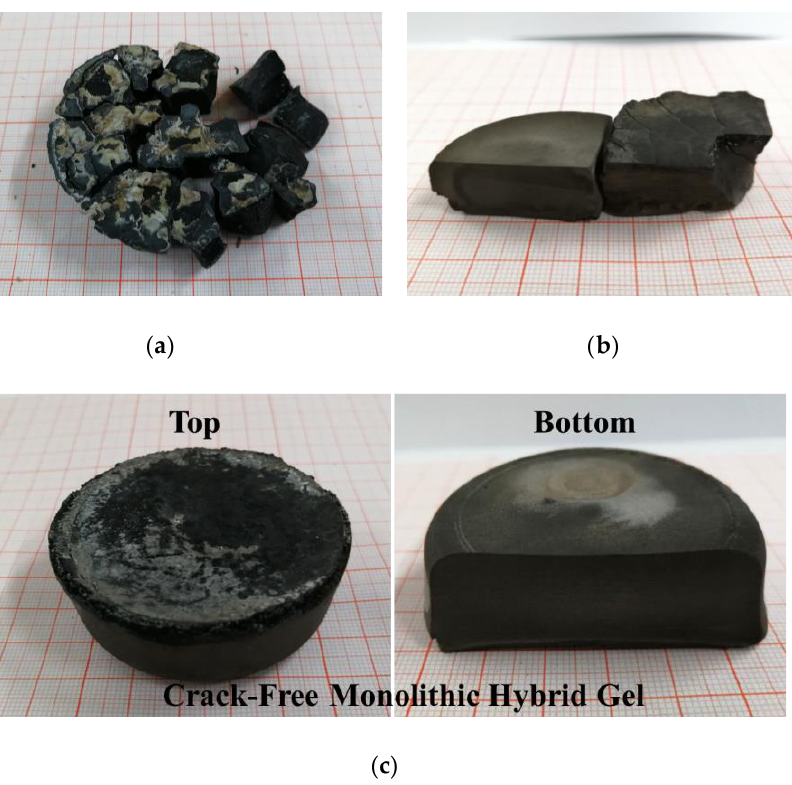
Figure 3. Photographs of the hybrid gels with various SDS concentrations in the starting sols: ( a ) SCB-S0; ( b ) SCB-S0.5; ( c ) SCB-S1.